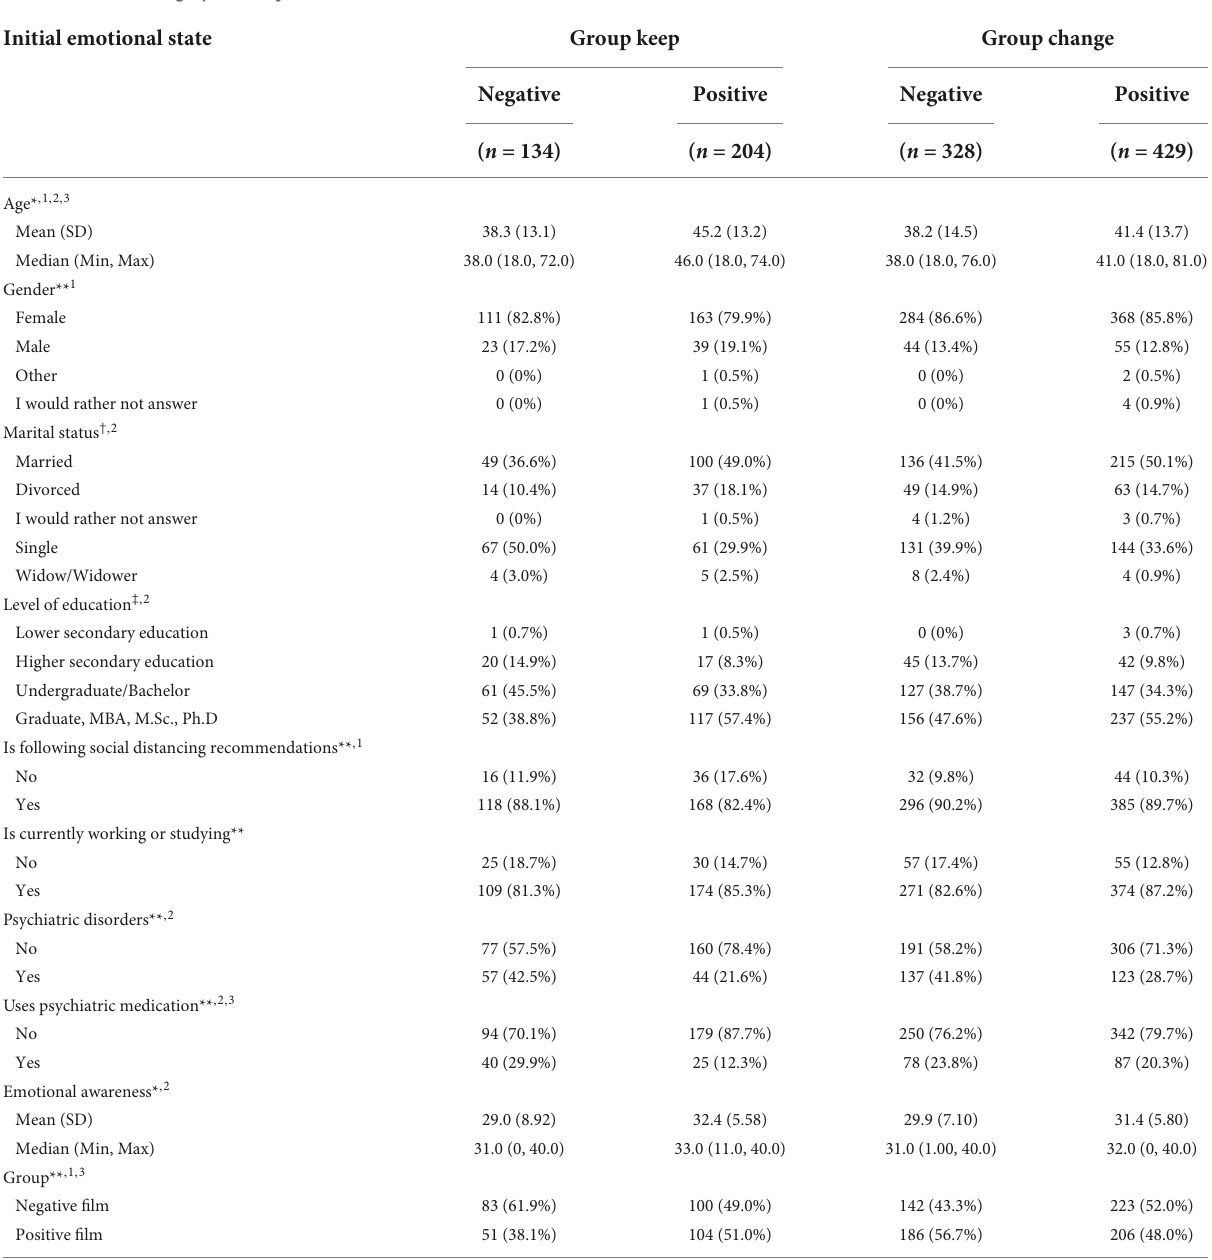
TABLE 2 Sociodemographic